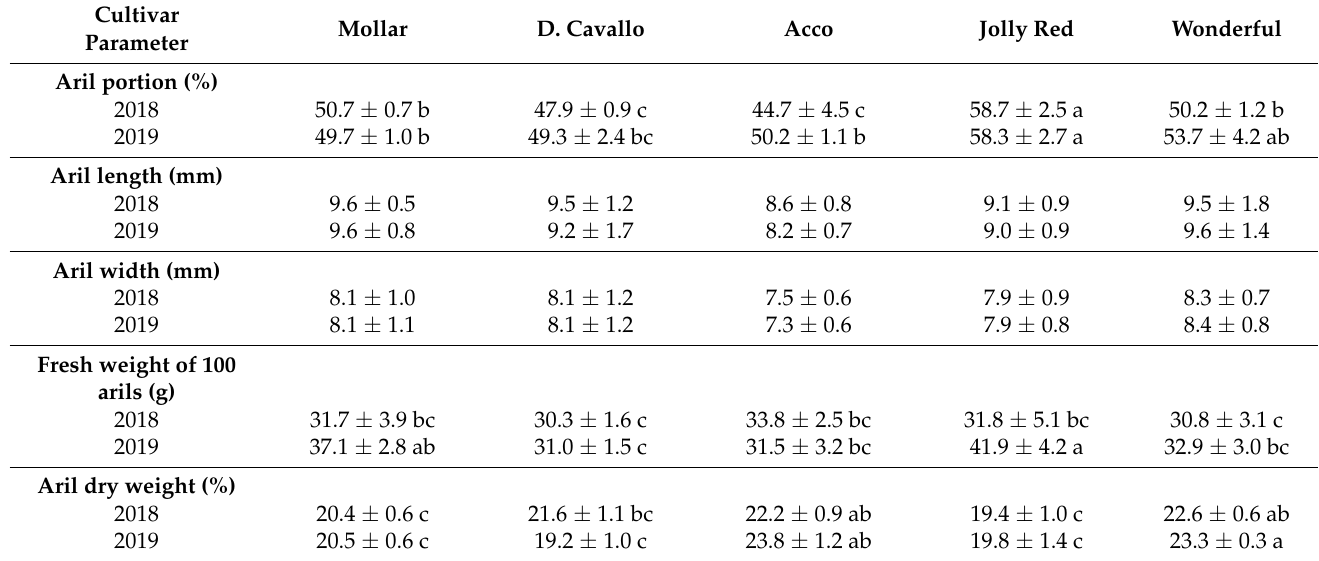
Table 3. Aril characteristics of different pomegranate cultivars in 2018 and 2019 seasons. Mollar D. Cavallo Acco Jolly Red